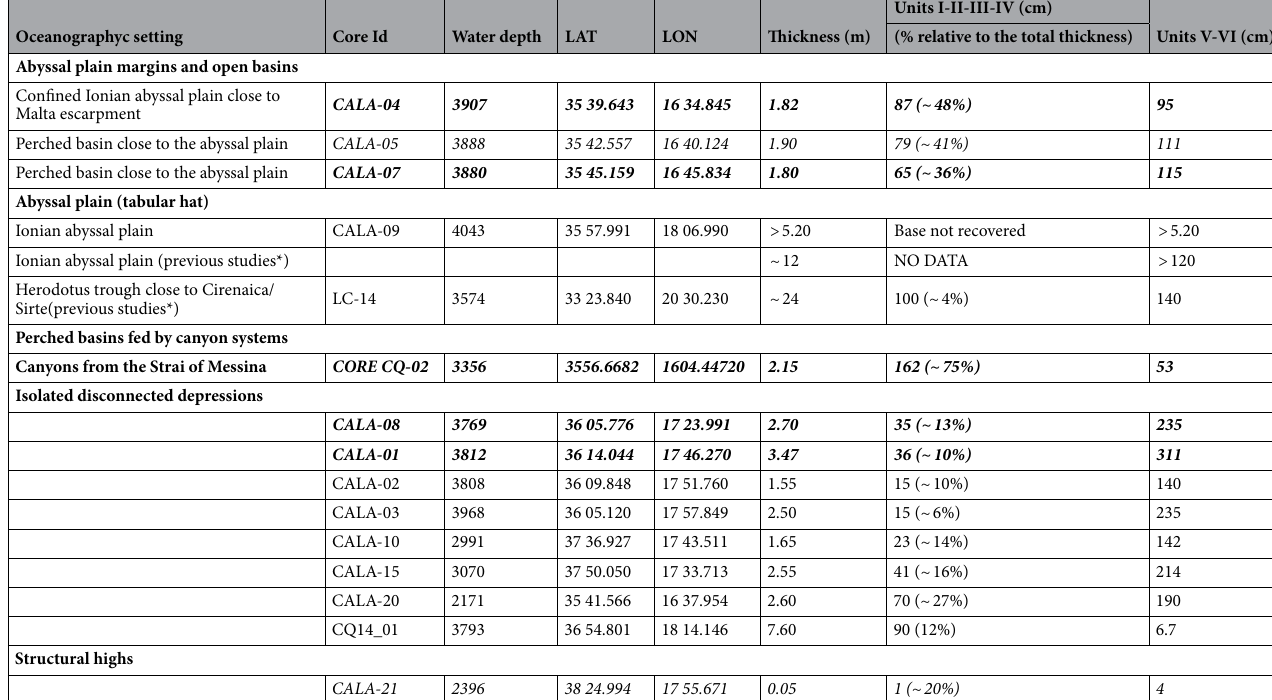
Table 1. Total HAT thickness, thickness of sandy-silty basal Units –I to –IV, and thickness of uppermost Units-V and -VI (homogenite and laminite) for available gravity cores in the different depositional settings. Bold: cores discussed in this study that were not used to reconstruct HAT structure and composition before this study. We used Chirp seismic profiles to estimate HAT thickness where sediment cores are not available and this was used to make a first order estimate for the total volume of the HAT resedimented material in the Mediterranean Sea. *: we integrated our analyses considering sedimentological information from the literature 19,22,33,64 . Cores marked in italics are shown in this